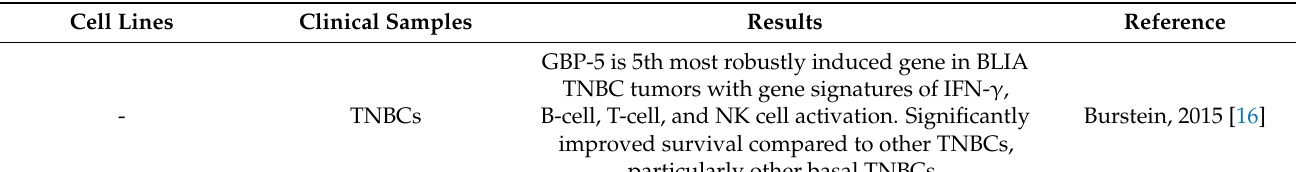
Table 2. Manuscripts addressing GBP-5 and breast cancer. If you want to move Table 1 to the introduction then you should relabel this Table 2 and move it there